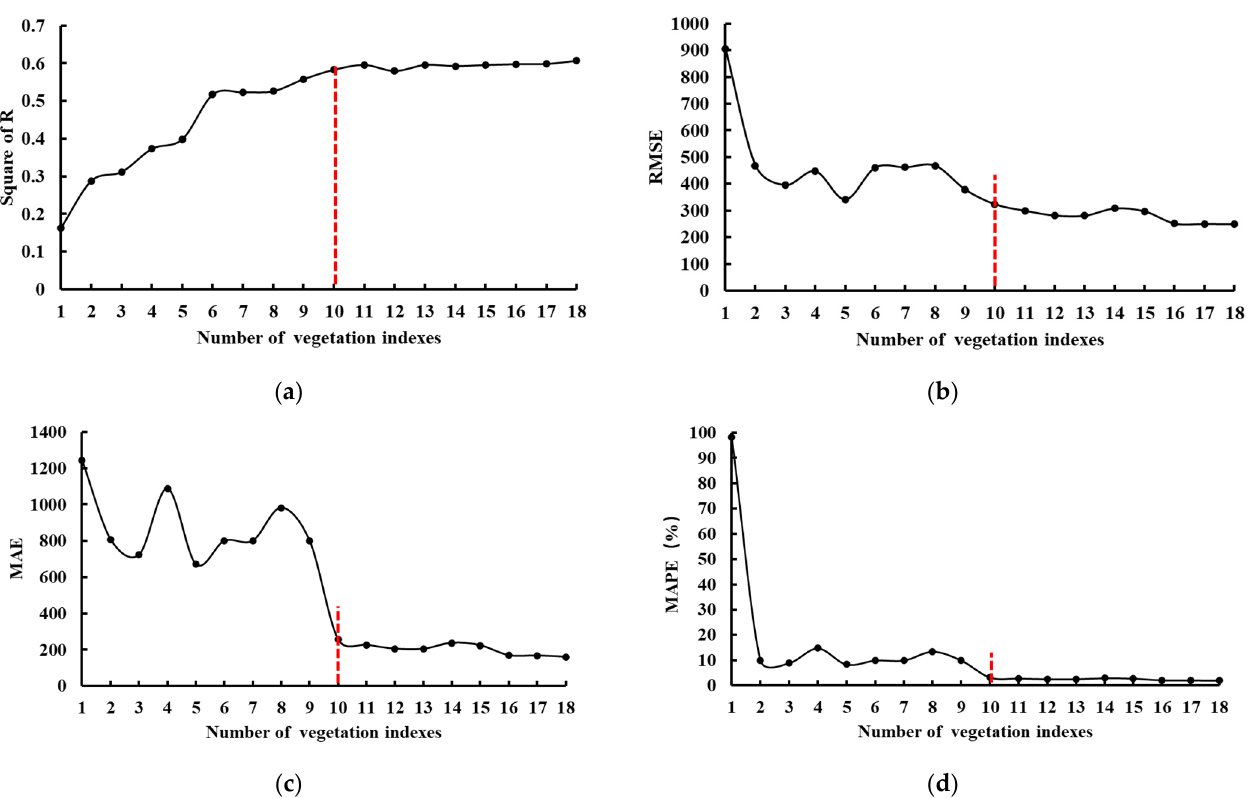
Figure 8. The relationship between the ( a ) R 2 , ( b ) RSME, ( c ) MAE, and ( d ) MAPE and the number of vegetation indexes.